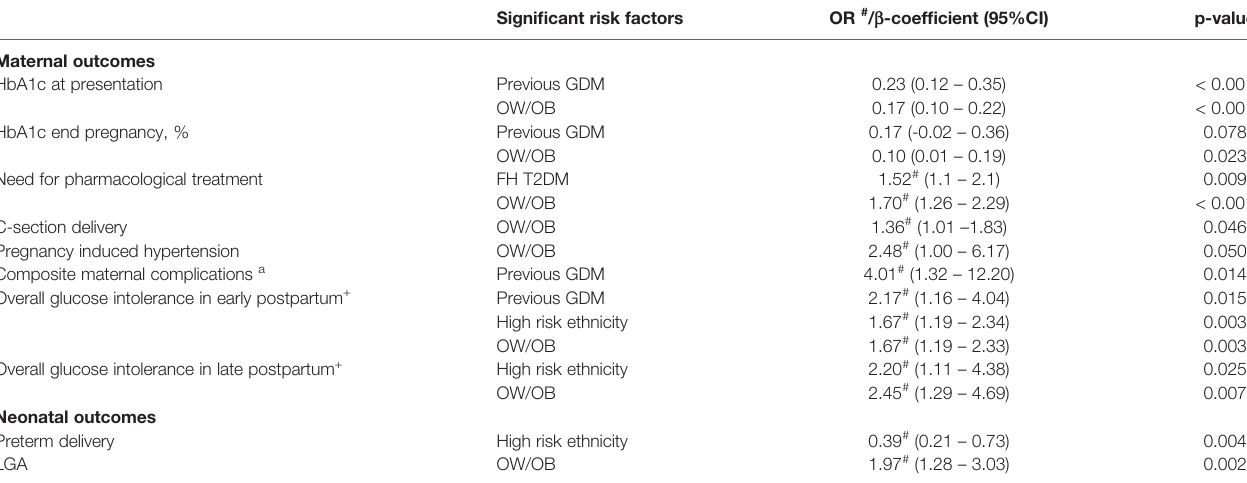
TABLE 3 | Independent impact of individual risk factors on maternal and neonatal